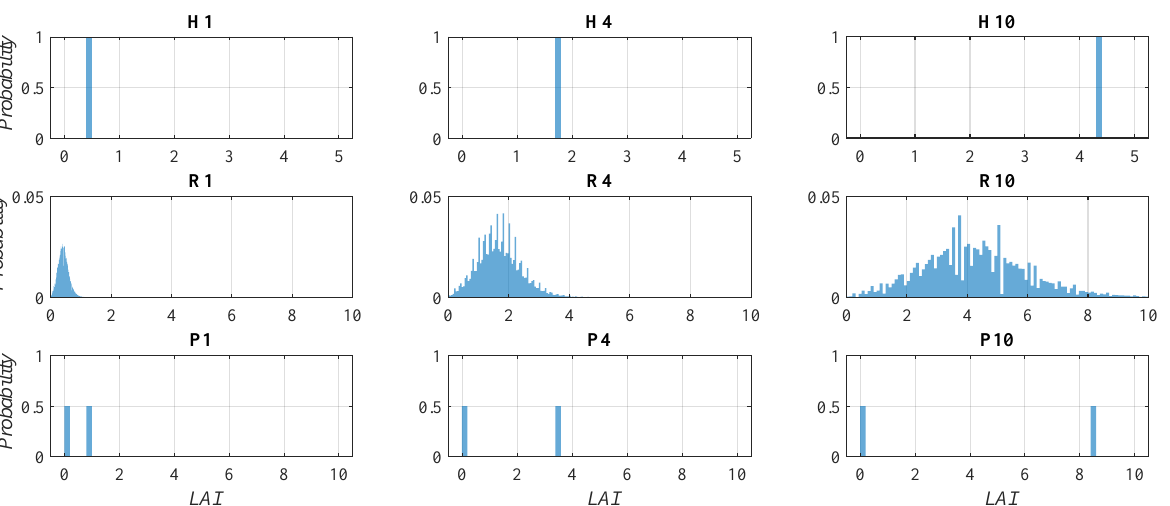
The normalized probability distributions for all cases are presented in Figure 6.